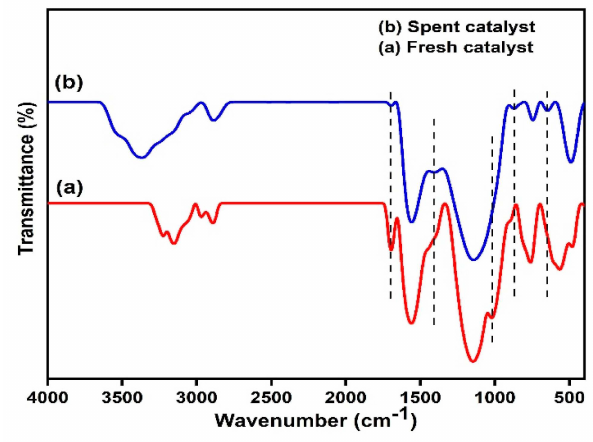
Figure 15. FTIR spectrum of the (a) fresh and (b) spent catalysts after the fifth cycle.